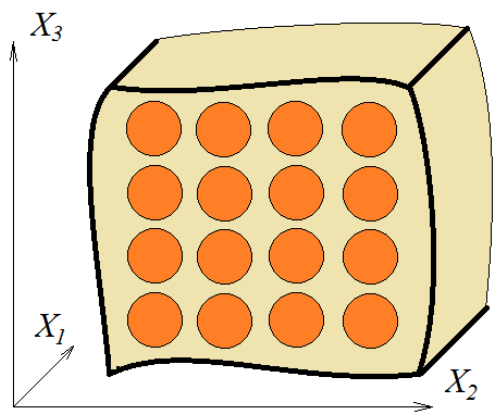
Figure 2. A micromechanical model of a one-dimensional fiber material.